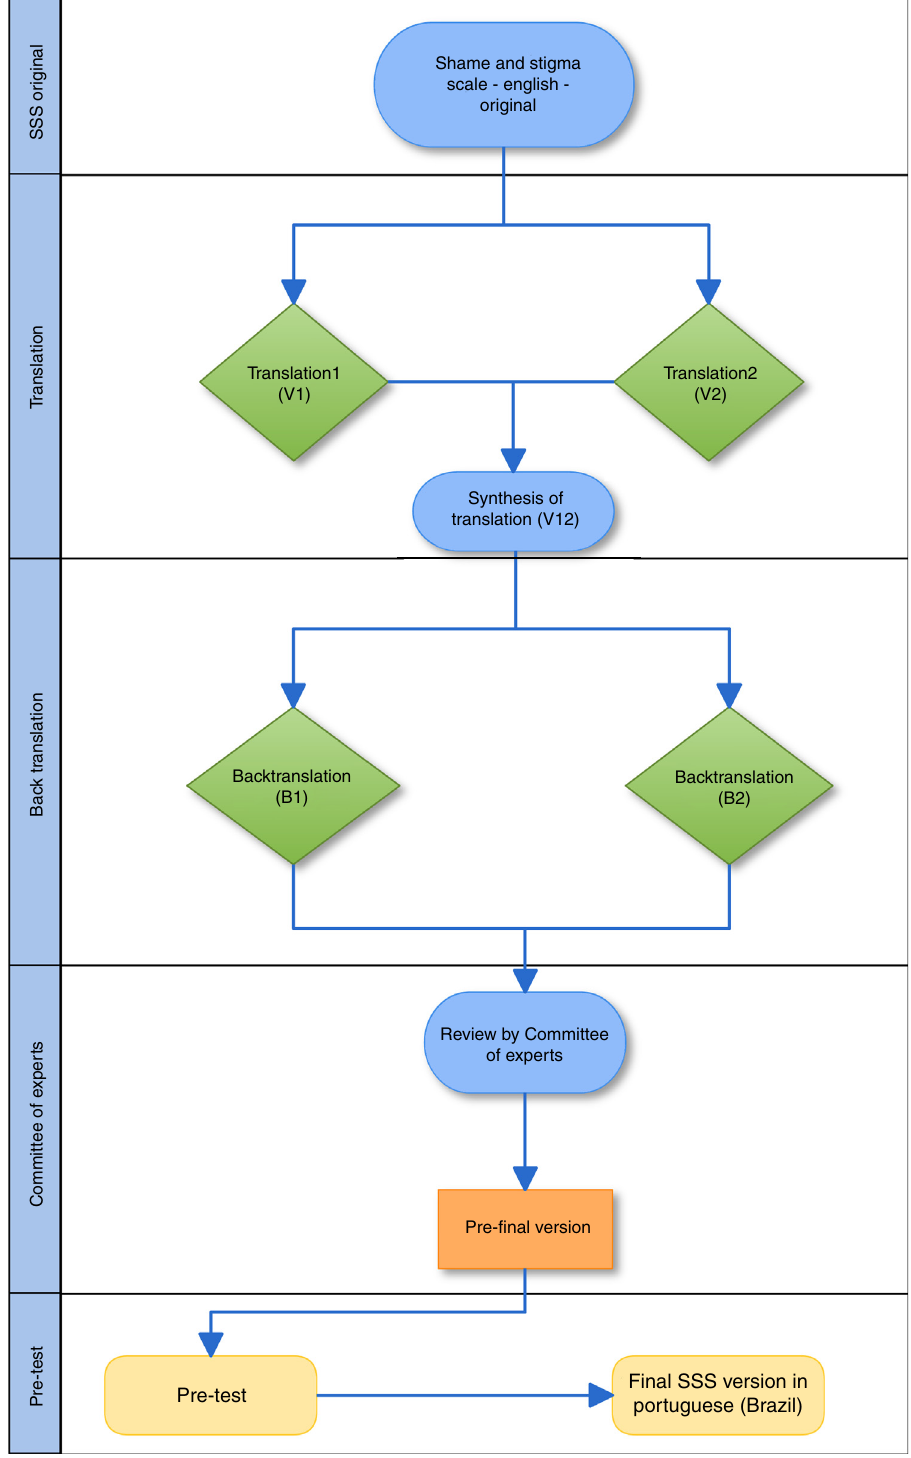
Figure 1 Flowchart of the translation and cultural adaptation